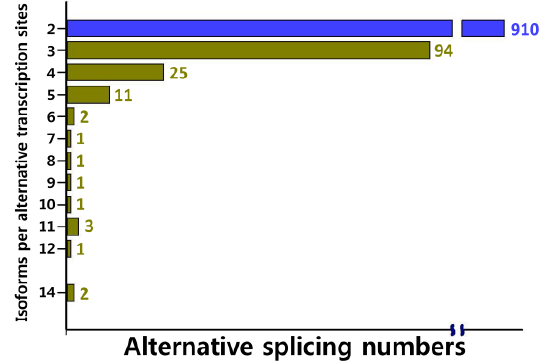
Figure 4. Number of isoforms identified in the alternatively spliced kenaf unigenes.